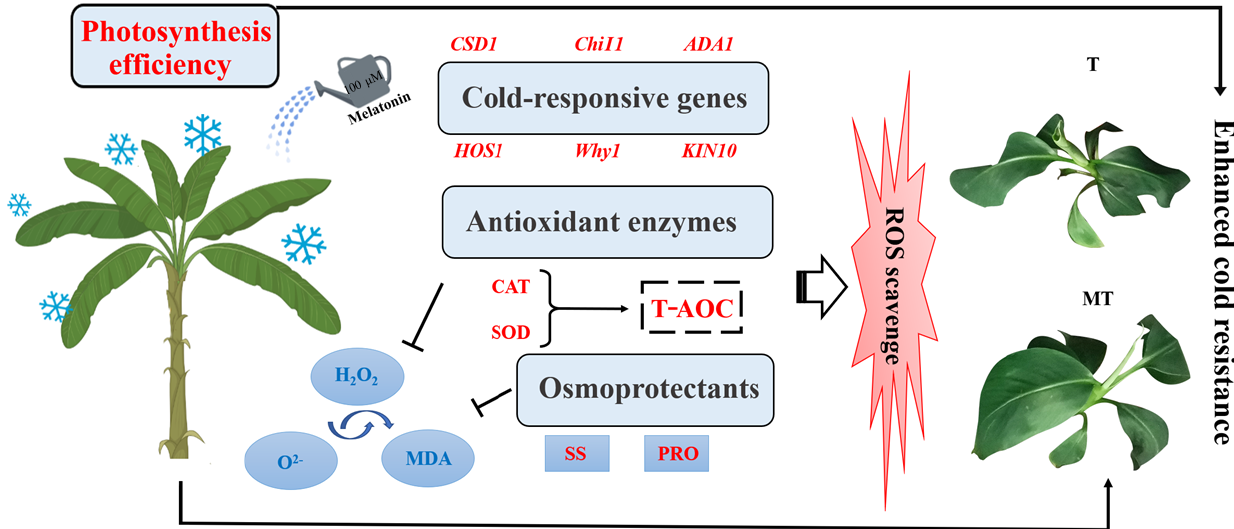
Figure 7. Schematic diagram for the mechanism of melatonin-improved cold resistance of banana. Red and blue font represents upregulation and downregulation under low-temperature treatment, respectively. CSD1C : copper/zinc superoxide dismutase 1C; ChiI1 : chitinase anti-freeze protein I1; ADA1 : adaptor 1; HOS1 : high expression of osmotically responsive gene 1; Why1 transcription factor WHIRLY 1; KIN10 : SNF1-related protein kinase catalytic subunit alpha 10; CAT: catalase; SOD: superoxide dismutase; T-AOC: total antioxidant capacity; H 2 O 2 : hydrogen peroxide; O 2 − : superoxide anion; MDA: malondialdehyde; SS: soluble sugar; PRO: proline; T: low-temperature treatment; MT: combined melatonin and low-temperature